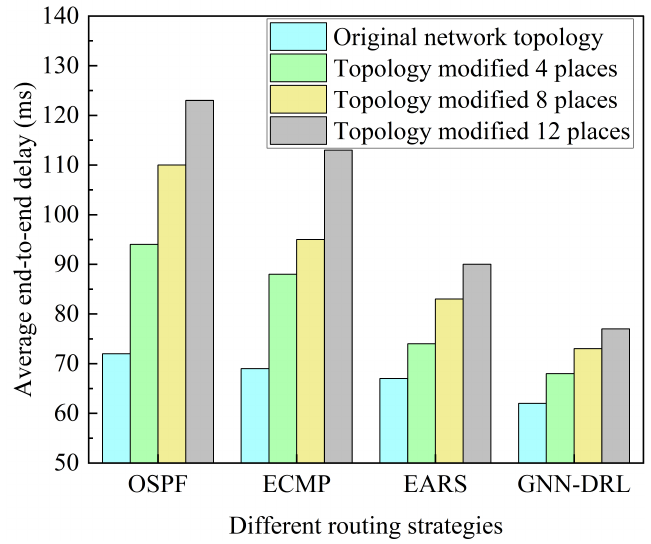
Figure 14. The effect of generalization on average end-to-end